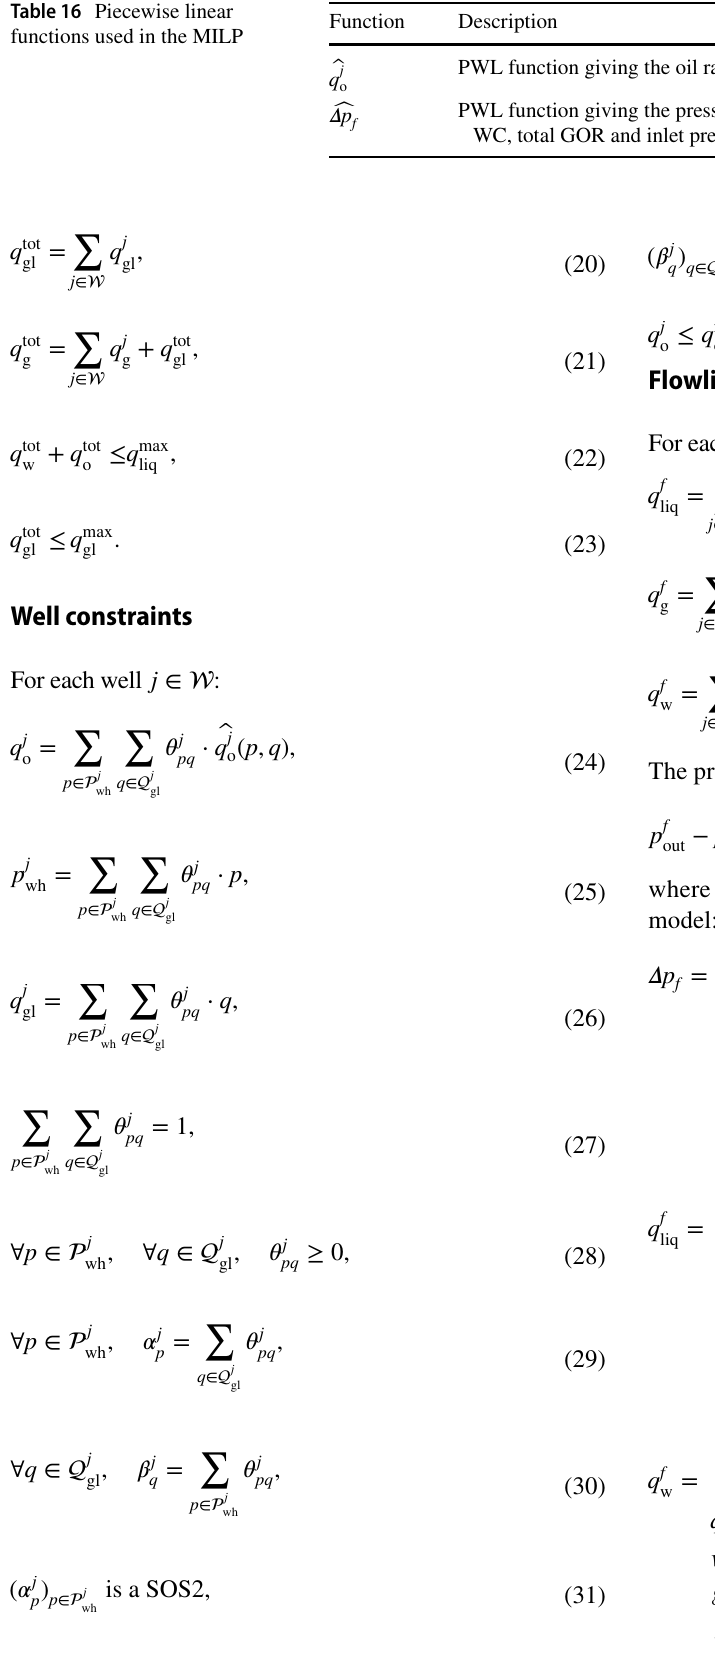
Table 16 Piecewise linear functions used in the MILP